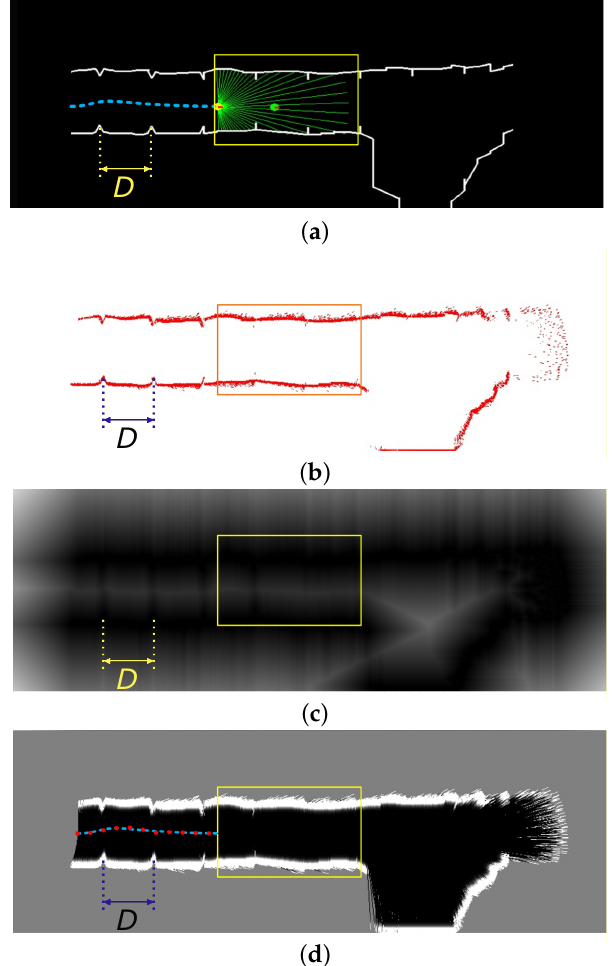
Figure 9. SLAM solution of the El Teniente tunnel showing the ground truth map, trajectory, and distance between landmarks ( a ); the laser rangefinder scan ( b ); the Voronoi distance transform of the scan ( c ); and the estimated grid map and trajectory results ( d